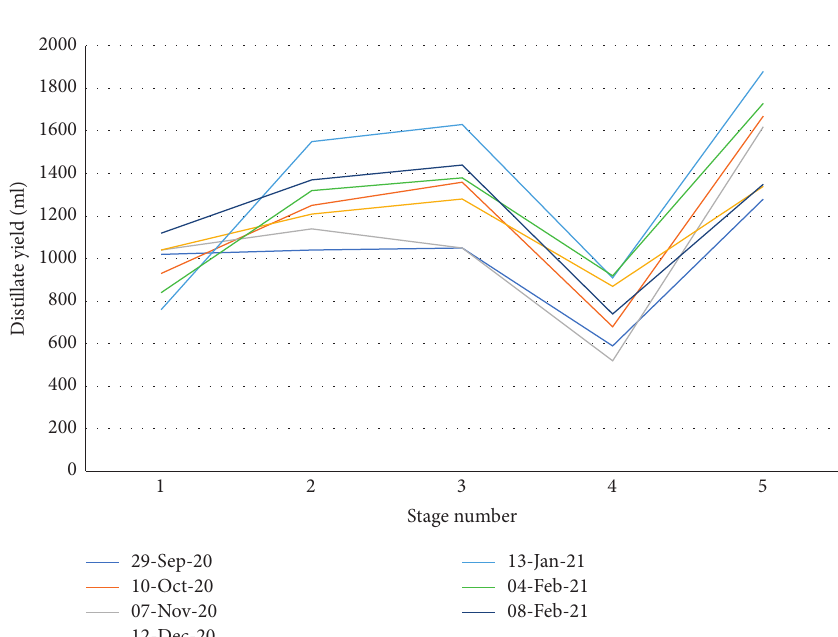
Figure 7: Distillate yield pattern versus stage